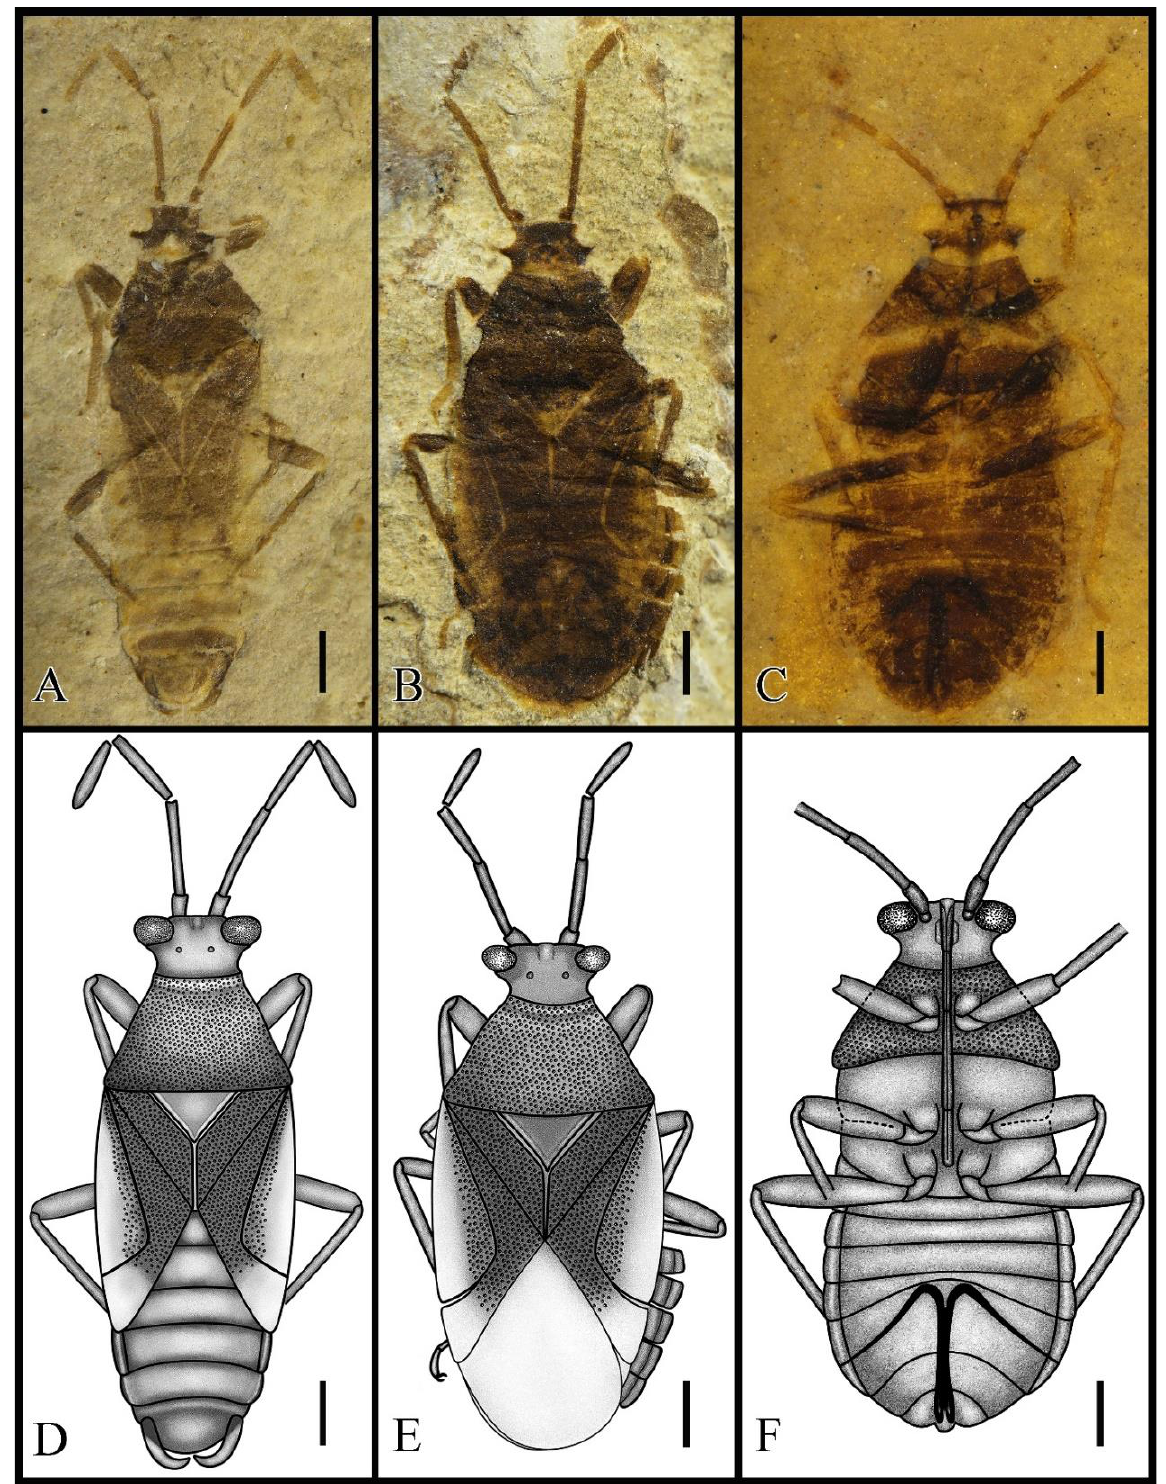
Figure 1. Varicapitatus sinuolatus gen. et sp. nov. from the Early Cretaceous of Huangbanjigou, China. ( A , D ) Holotype, male, CNU-HET-LB2022003. Photograph and line drawing in dorsal view. ( B , E ) Paratype, female, CNU-HET-LB2022004. Photograph and line drawing in dorsal view. ( C , F ) Paratype, female, CNU-HET-LB2022005. Photograph and line drawing in ventral view. Scale bars: ( A – F ) = 0.5 mm.